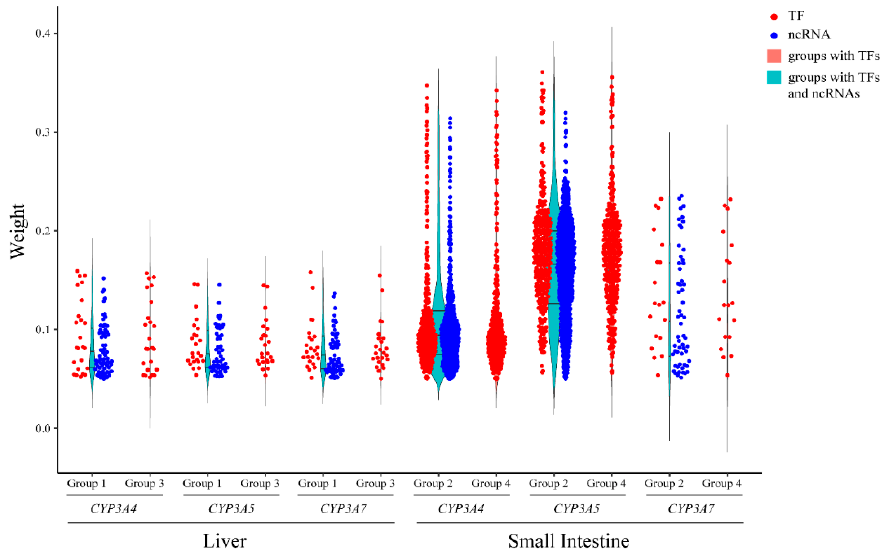
Figure 3. Comparison of CYP3A -associated transcription factors (TFs) in liver and small intestine with and without ncRNAs. The red dots represent the overlapping TFs associated with each CYP3A in liver and small intestine with and without ncRNAs. The blue dots represent the ncRNAs in liver and small intestine (group 1 and group 2). The red violin plots represent all TFs associated with each CYP3A in liver and small intestine (group 3 and group 4), and the green violin plots represent all TFs and ncRNAs associated with each CYP3A in liver and small intestine (group 1 and group 2). The y-axis has the weight values calculated by WGCNA.